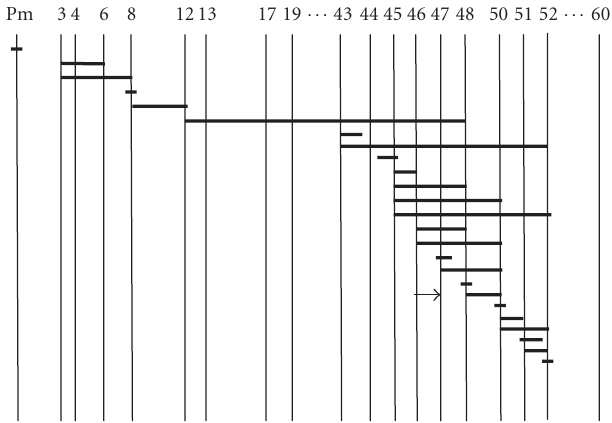
Figure 1. Analysis of dystrophin gene by multiplex PCR. I: patient with deletion of exon 45, II: patient with deletion of exon 48, and III: normal control. The numbers at the right indicate the amplified exons.